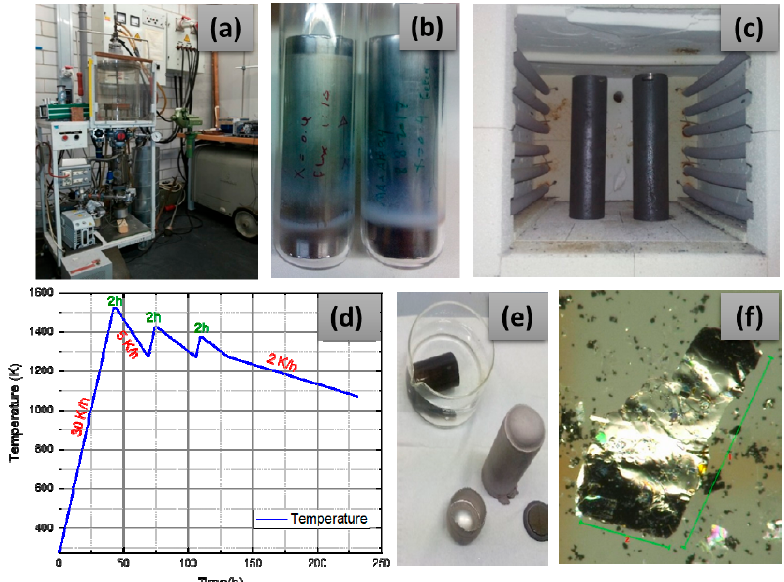
Figure 1. The tools used for the crystal growth process. ( a ) The argon arc machine used for wielding the niobium ampoule. ( b ) The quartz tube containing the sample sealed under vacuum. ( c ) The box furnace with a stainless-steel shield containing the sample. ( d ) The temperature profile for the crystal growth with multistep crystallization. ( e ) The removal of the flux using distilled water. ( f ) An